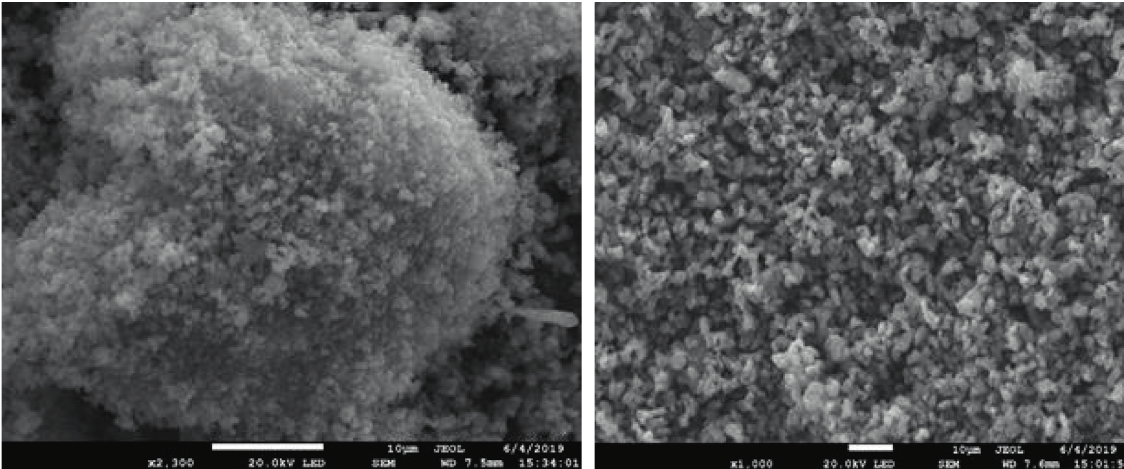
Figure 9: SEM images of CaO-NPs which were calcined at 800 °